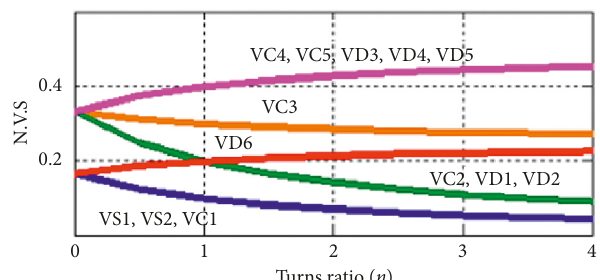
Figure 5: Voltage gain against the duty cycle by considering different turns ratios.